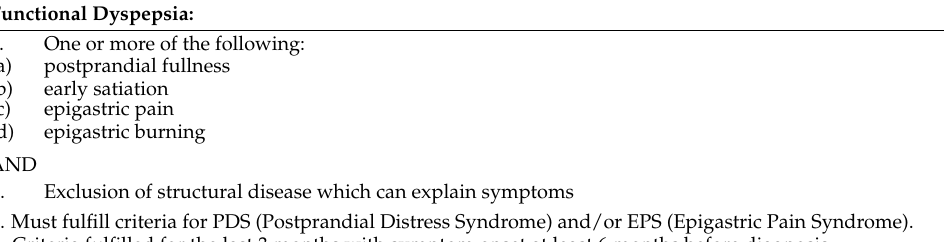
Table 1. Rome IV diagnostic criteria of functional dyspepsia modified from